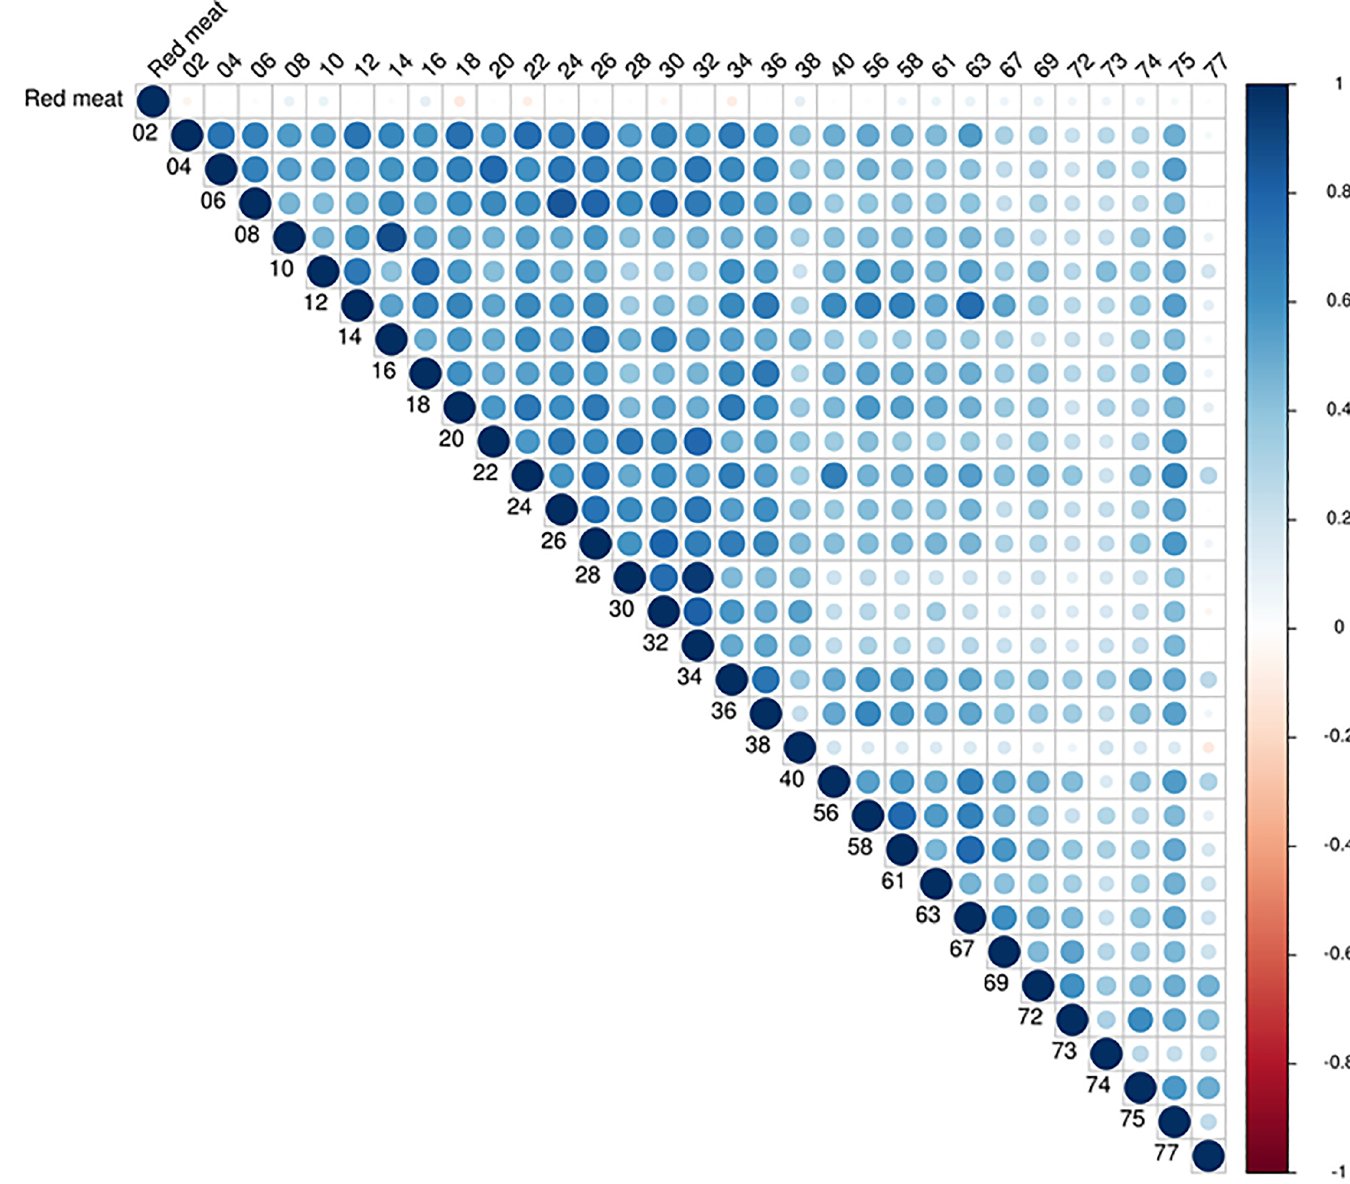
PLOS ONE | https://doi.org/10.1371/journal.pone.0197464 June 18,